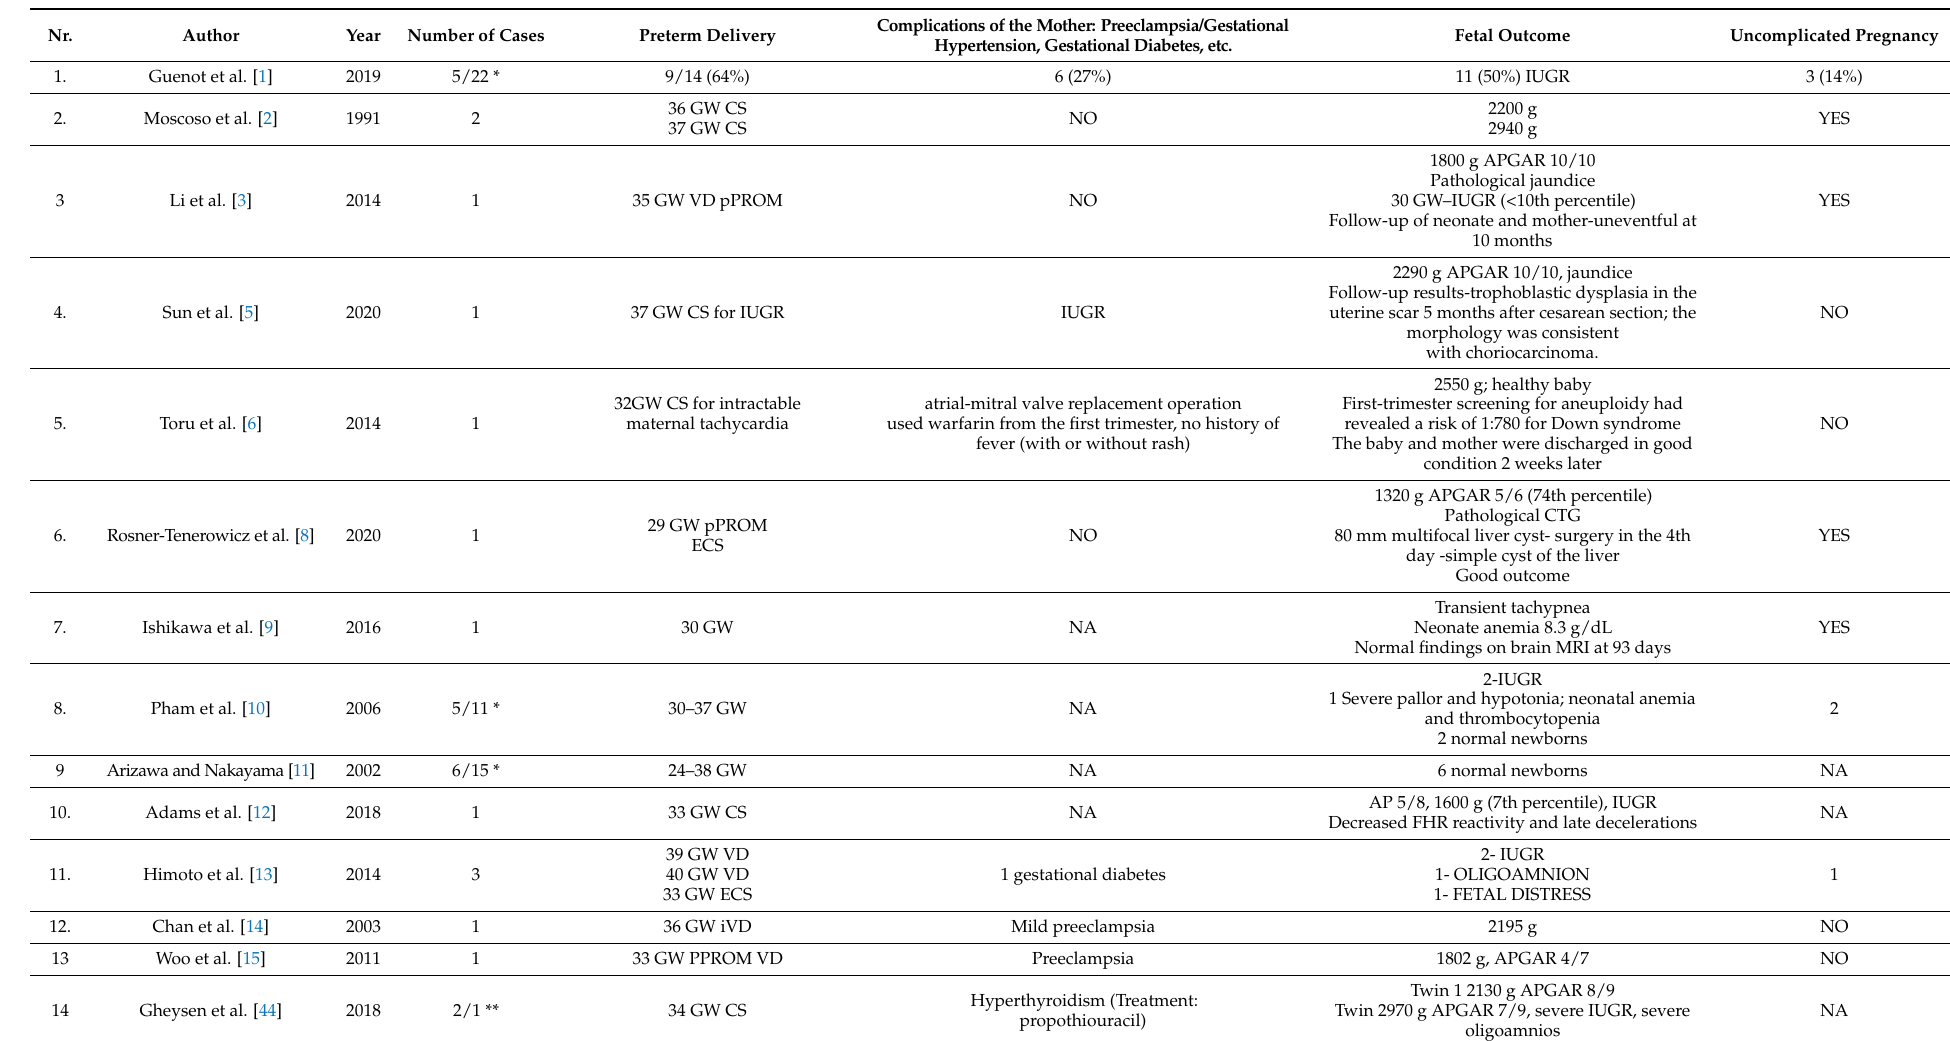
Table 2. Literature review for case reports and case series of PMD; Fetal outcomes and complications during